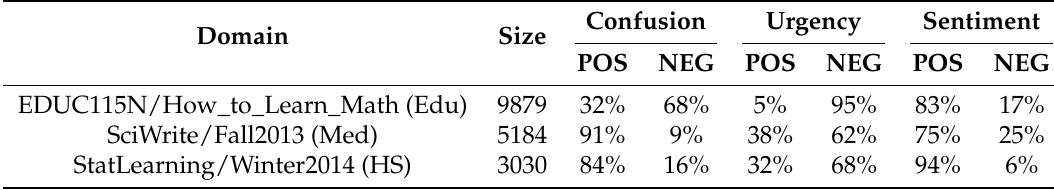
Table 2. Evaluation dataset for cross-domain MOOC forum post